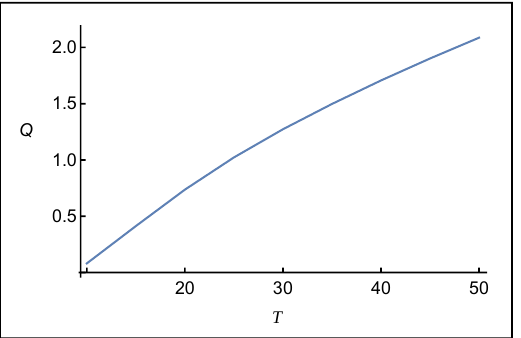
Figure 10. Dependence of Q on the duration of sales T . Values of the parameters of the dynamic system: a = 10, U 0 = 1, k 1 =